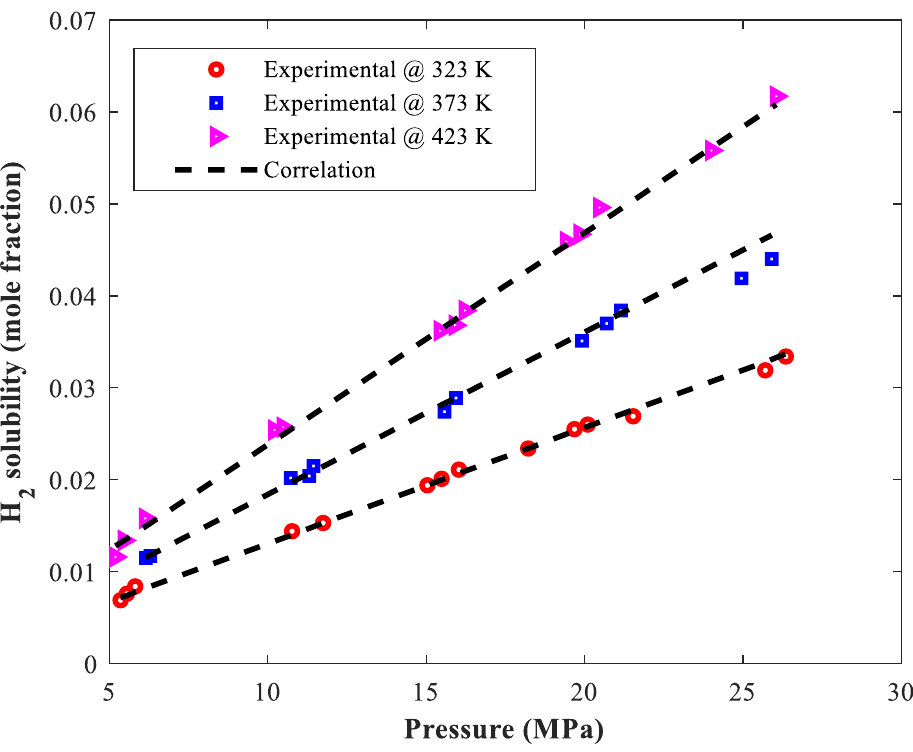
Figure 8. Actual and modeling values for the furfuryl alcohol-hydrogen equilibrium behavior.